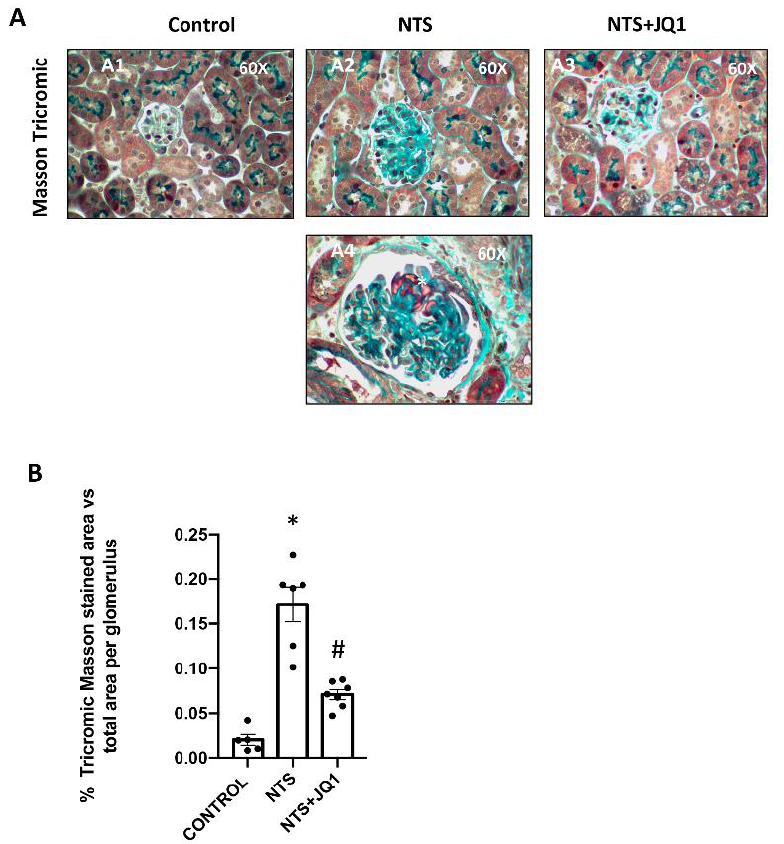
Figure 1. ( A ) JQ1 reduces glomerulosclerosis in nephrotoxic nephritis. Glomerulonephritis was induced in C57Bl/6 mice by the administration of NTS (A2, A3, A4), and mice were studied 10 days later. Mice were treated daily with JQ1 (100 mg/kg/day) (A3) or vehicle (A1), starting before the first NTS injection. In paraffin-embedded kidney sections, kidney morphology was evaluated by Masson Trichromic staining, and showed increased collagen content (A2) and fibrinoid necrosis (A4) in NTS mice. JQ1 diminished glomerular collagen deposition and severe glomerular lesions (A3), including fibrinoid necrosis (*). Panels show a representative animal from each group (600 × magnification) focused on the glomerulus. ( B ) Masson Trichromic staining quantification. Scale bar represents 50 µ m. * p < 0.05 vs. control; # p < 0.05 vs. NTS-injected mice.